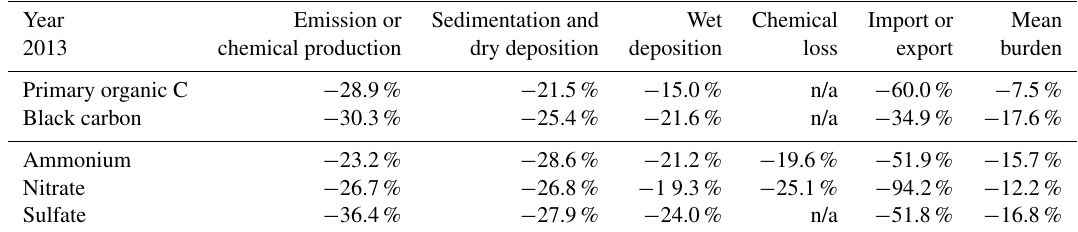
Table 17. Same as Table 16 but for 2013.